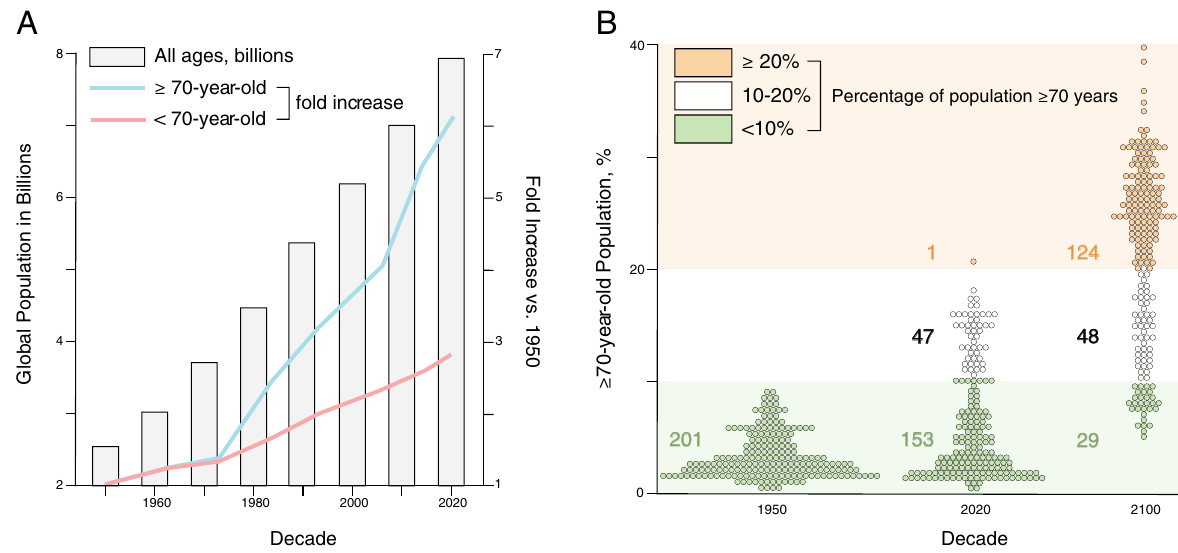
Fig. 1 Global aging demographics. A The world population continues to grow and has reached nearly 8 billion people (bars). A preeminent increase has occurred in those older than 70 years of age (blue line), outpacing those younger than 70 years of age (pink line). B While in 1950 a ‘ youthful ’ age distribution (green) typi fi ed all geographies, by 2020 a fourth of the globe had transitioned to an ‘ aging ’ structure (white). Forecasts for 2100 imply that over 80% percent of all territories/areas will exhibit an ‘ aging ’ or ‘ advanced aging ’ composition (orange). Percent of population ≥ 70 years of age is strati fi ed and color-coded in <10% (green), 10 – 20% (white), and ≥ 20% (orage) strata.